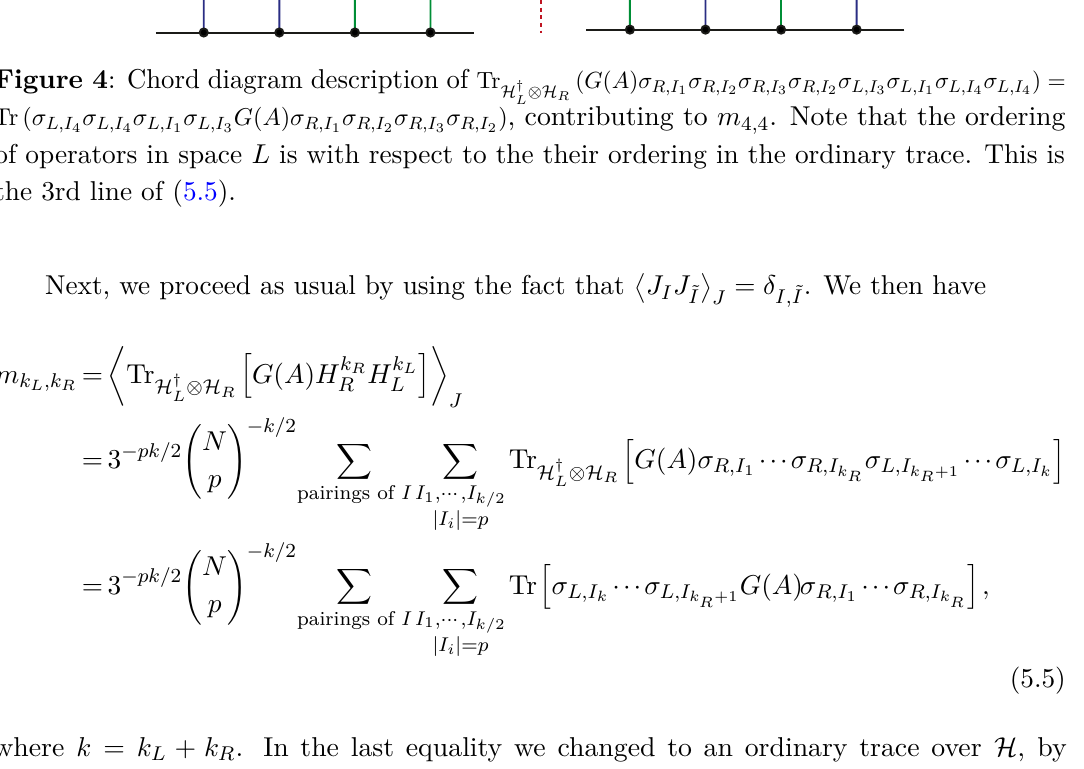
Figure 4 : Chord diagram description of Tr Tr ( σ L,I 4 σ L,I 4 σ L,I 1 σ L,I 3 G